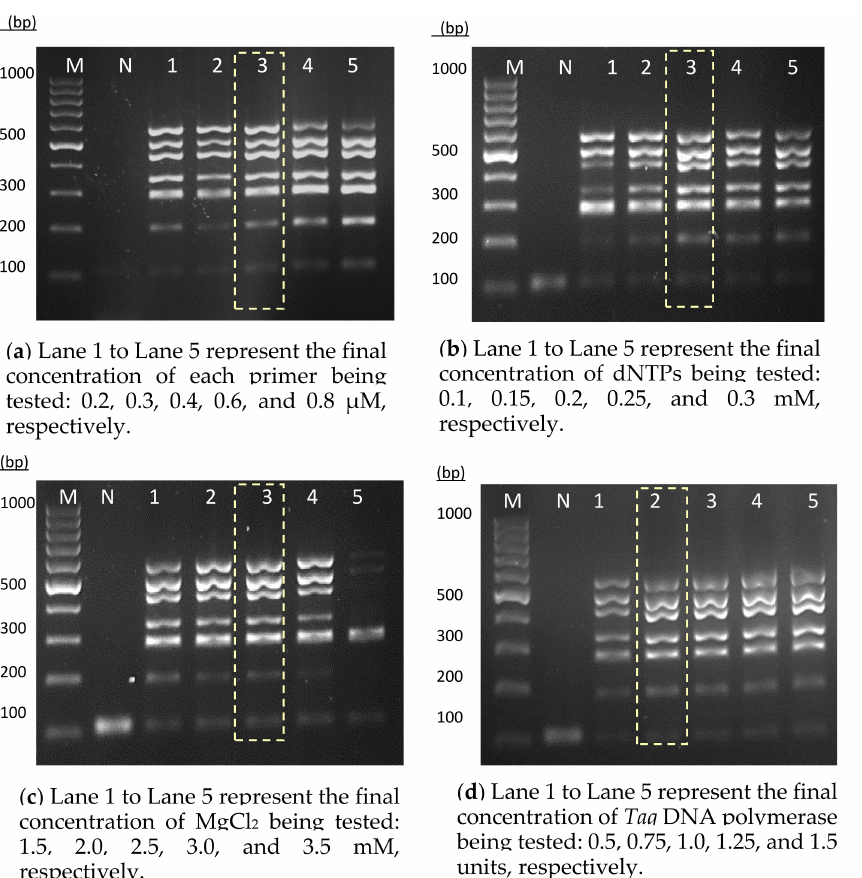
Figure 1. Optimization of the PCR components for the heptaplex PCR assay: ( a ) primers, ( b ) dNTPs, ( c ) MgCl 2 , and ( d ) Taq DNA polymerase enzyme. Lane M: 100 bp DNA ladder (Fermentas, Provincetown, MA, USA); Lane N: IAC; Lanes 1–5 are the corresponding amplicons of targeted genes under different conditions. The highlighted lanes represent the optimal concentrations of primers, dNTPs, MgCl 2 , and Ta DNA polymerase used for this